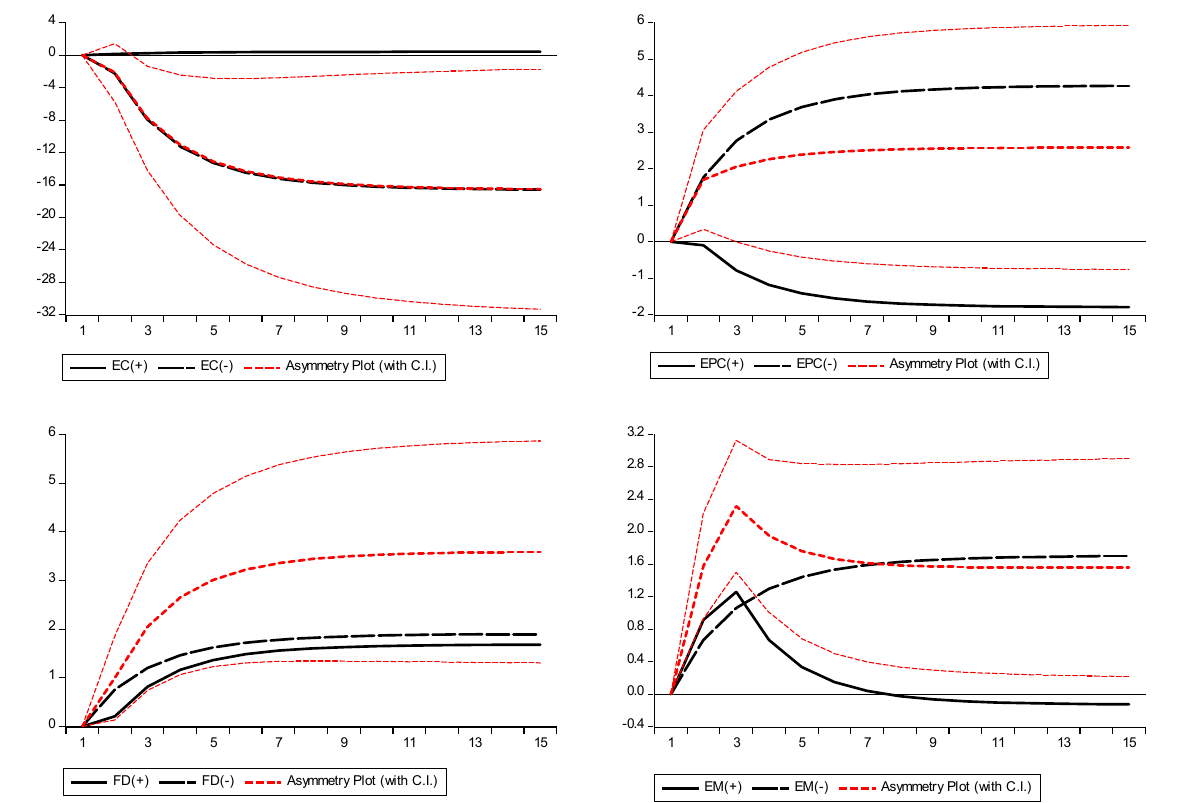
Figure 3. Dynamic multiplier adjustments of energy consumption, electric power consumption, financial development, and energy imports on economic growth. Table 7. Causality analysis of positive and negative